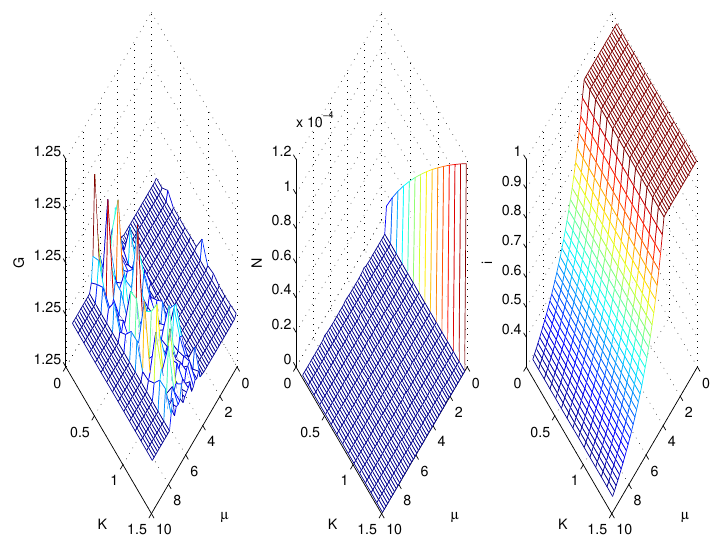
Figure 6. For low values of K independent of the interspecific transmission rate β , an apparent, but very low recovery of the red squirrels occurs, although they are all infected. The oscillations observed in the grey squirrel population are due to noise, as they attain the carrying capacity throughout the whole parameter space.